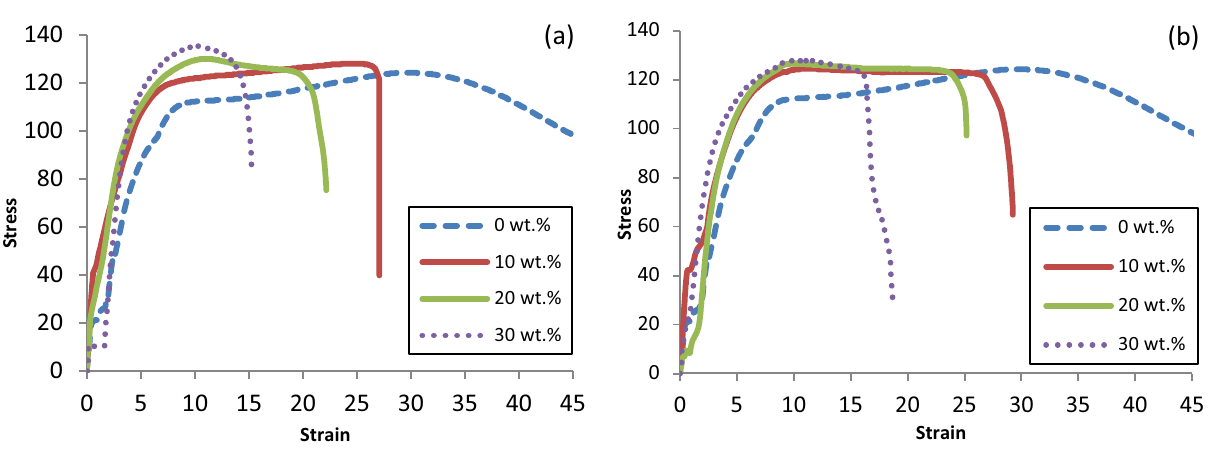
Figure 6. Stress–strain curves of; ( a ) LFPP and neat PP, ( b ) SFPP and neat